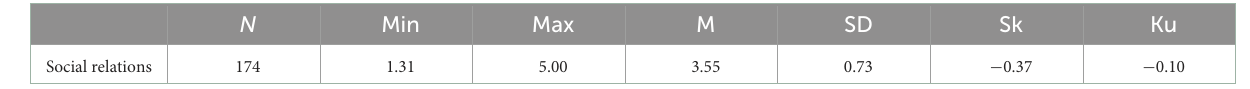
TABLE 4 Pearson’s coefficient of correlation between social and structural dimensions of school culture. Subscales Social Organization Spatial and relations of educational work